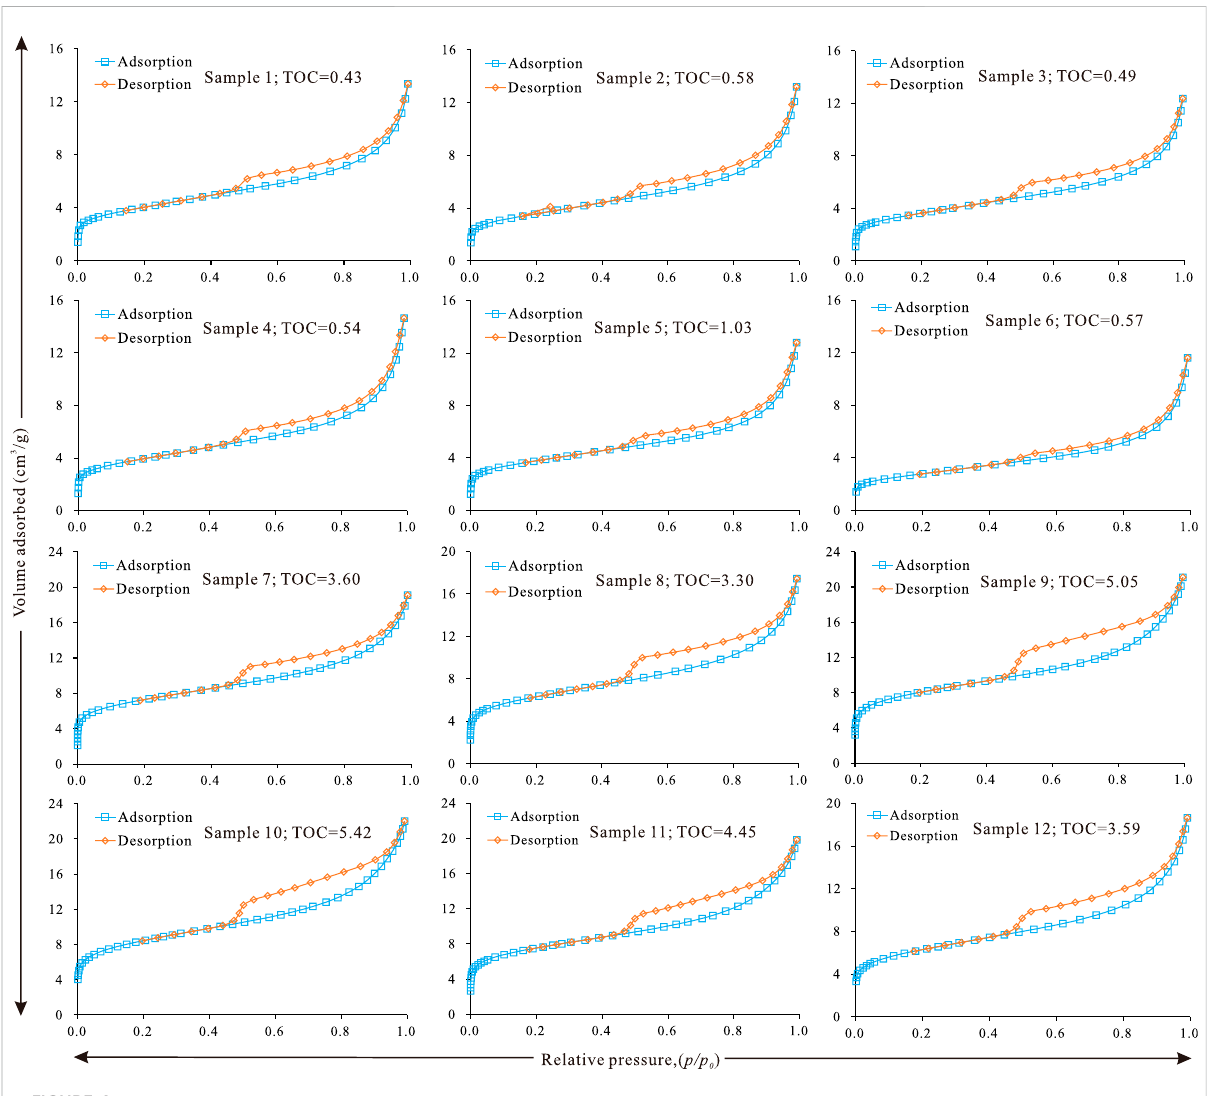
FIGURE 4 N 2 adsorption – desorption isotherms of shale